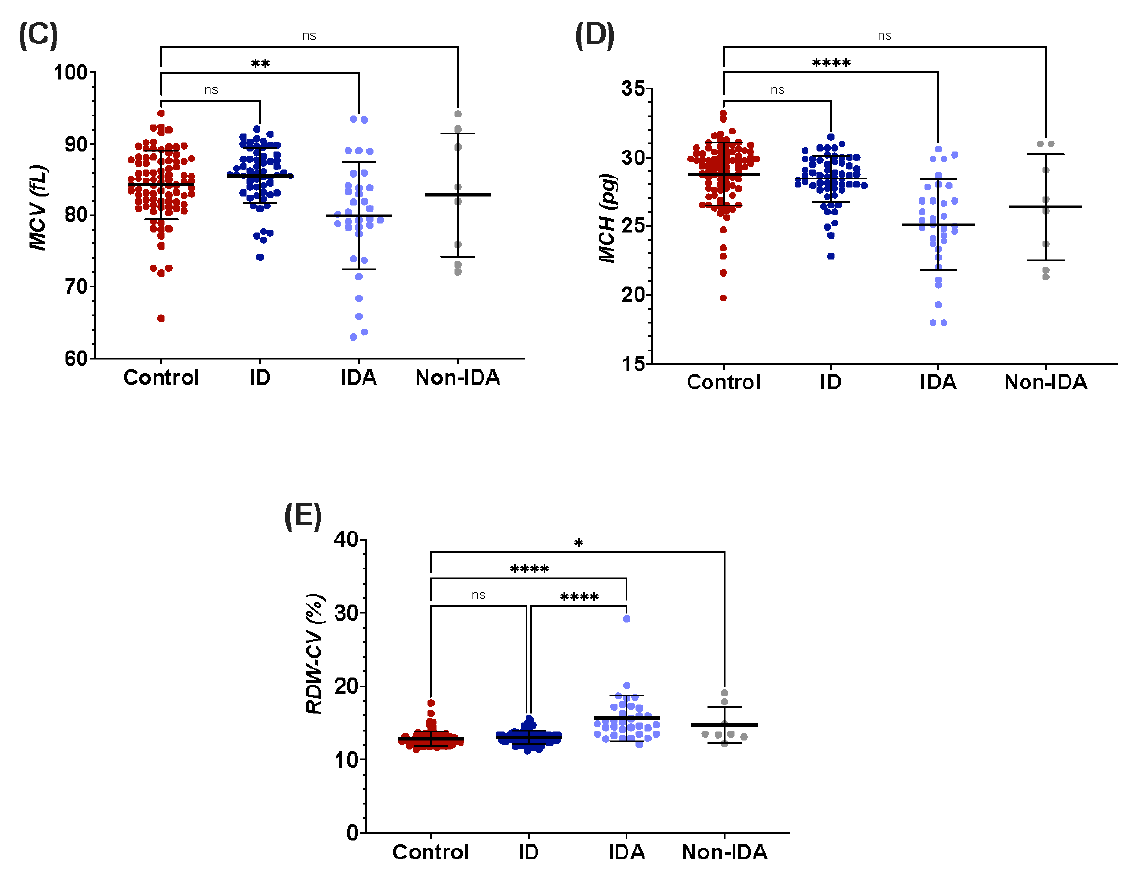
Figure 1. Plots for hematological parameters showing multiple comparisons between the four groups based on their iron levels using Dunn’s post-hoc. Horizontal and error lines represent mean and SD, respectively. * A p -value of <0.05 was considered statistically significant, ** for a p -value of <0.01, **** for a p -value of <0.0001, and (ns) for non-significant. ( A ) Multiple comparison plots for hemoglobin (Hb), ( B ) reticulocyte hemoglobin equivalent (Ret-He), ( C ) mean cell volume (MCV), ( D ) mean cell hemoglobin (MCH), and ( E ) red cell distribution width (RDW).